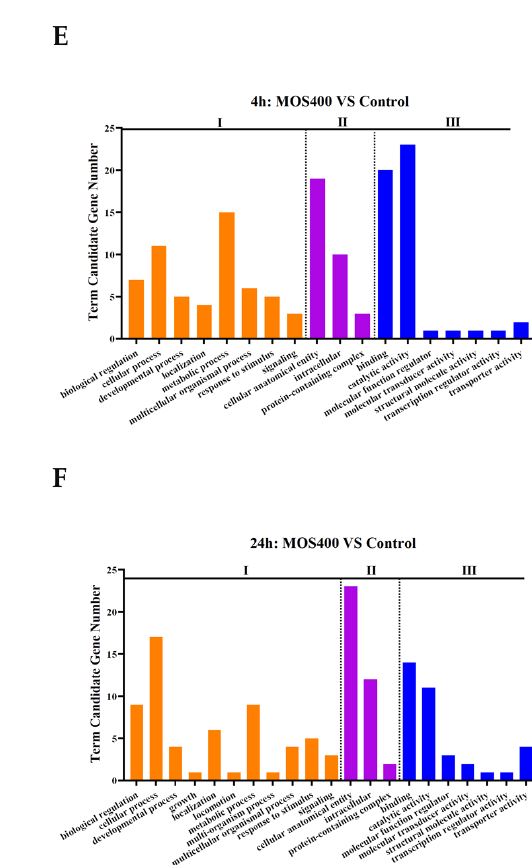
Figure 2. The mainly enriched Gene Ontology (GO) terms of identified DEGs. I: biological process, II: cellular component, III: molecular function. ( A – C ) was GO enrichment of DEGs between MOS200 and control groups at 0, 4 and 24 hpi, respectively. ( D – F ) was GO enrichment of DEGs between MOS400 and control groups at 0, 4 and 24 hpi, respectively.